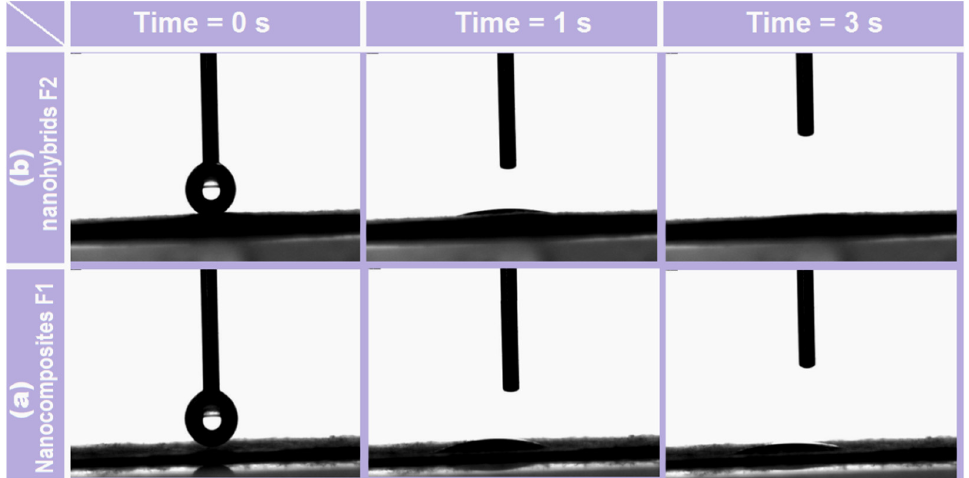
Figure 7. Water contact angle experimental results: ( a ) electrospun core–shell nanohybrids; ( b ) electrospun nanocomposites.